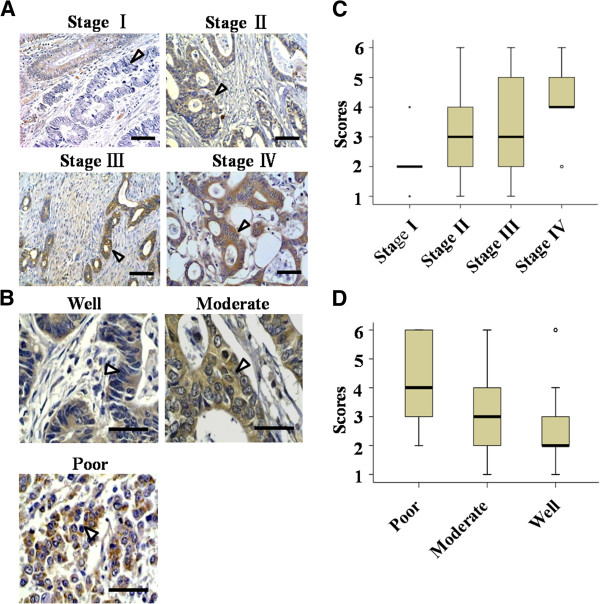
The level of CXCL14 expression was significantly correlated with TNM stage and histodifferentiation. A, strong immunoreactivity was more likely to present with late-stage CRC compared to early-stage CRC (P < 0.001). Bar, 50 μm. B, poorly differentiated colorectal tumors showed stronger immunoreactivity of CXCL14 than moderately and well differentiated colorectal tumors (P = 0.002). Bar, 25 μm. C and D, comparison of immunohistochemical scores of CXCL14 according to TNM stage (C) and histodifferentiation (D).